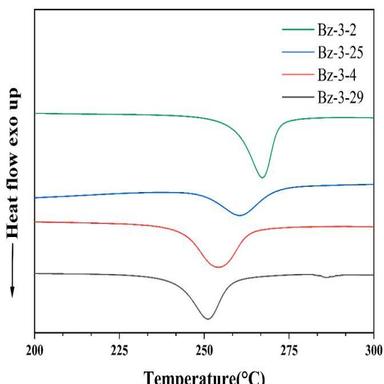
DSC curves of the examined benzoxazines.